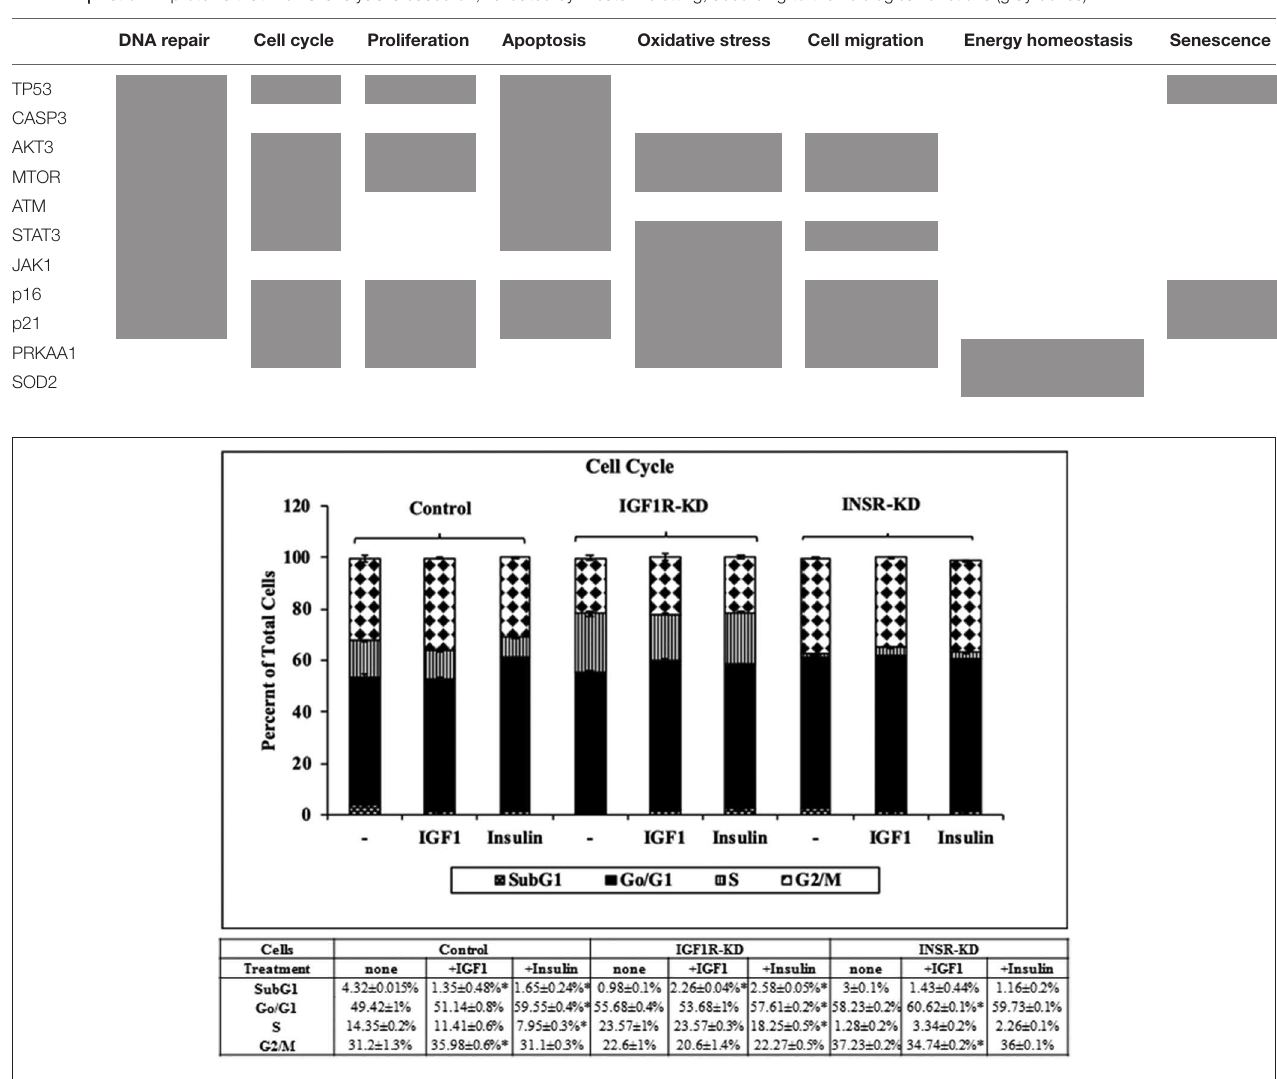
TABLE 2 | List of 11 proteins that BioNSi analysis is based on, validated by Western blotting, according to their biological functions (gray boxes).